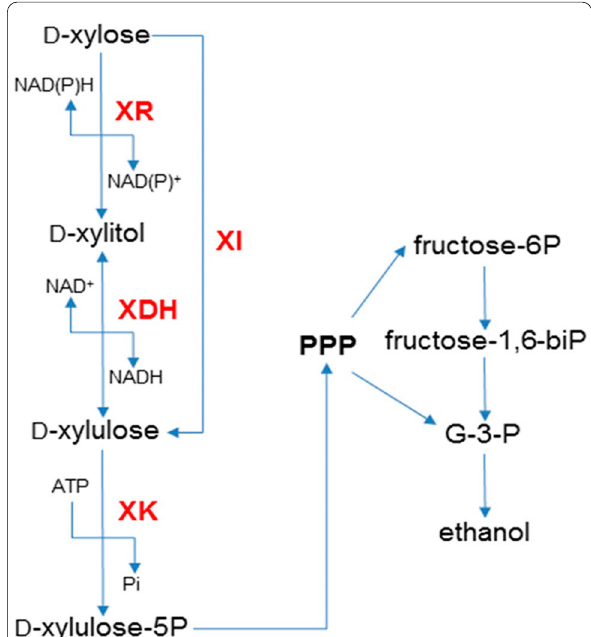
Fig. 3 Xylose fermentation in S. cerevisiae . The fungal pathway uses xylose reductase (XR) and xylitol dehydrogenase (XDH), whereas the bacterial pathway uses xylose isomerase (XI). Both pathways produce d -xylulose which is converted to d -xylulose-5P by endogenous xylulokinase (XK). d -Xylulose-5P then enters the pentose phosphate pathway (PPP), where it is further metabolized to form ethanol under appropriate conditions. Arrows indicate the direction of the chemical reactions (Moysés et al.